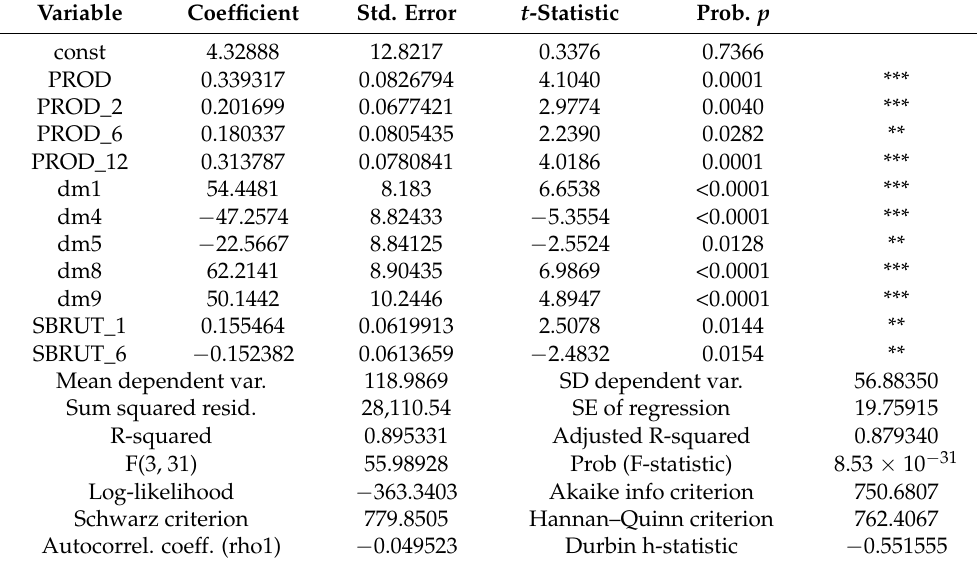
Table A3. Dependent variable: gross sales revenues in period t (SBRUT) (observation 2001:01–2007:12 (N =